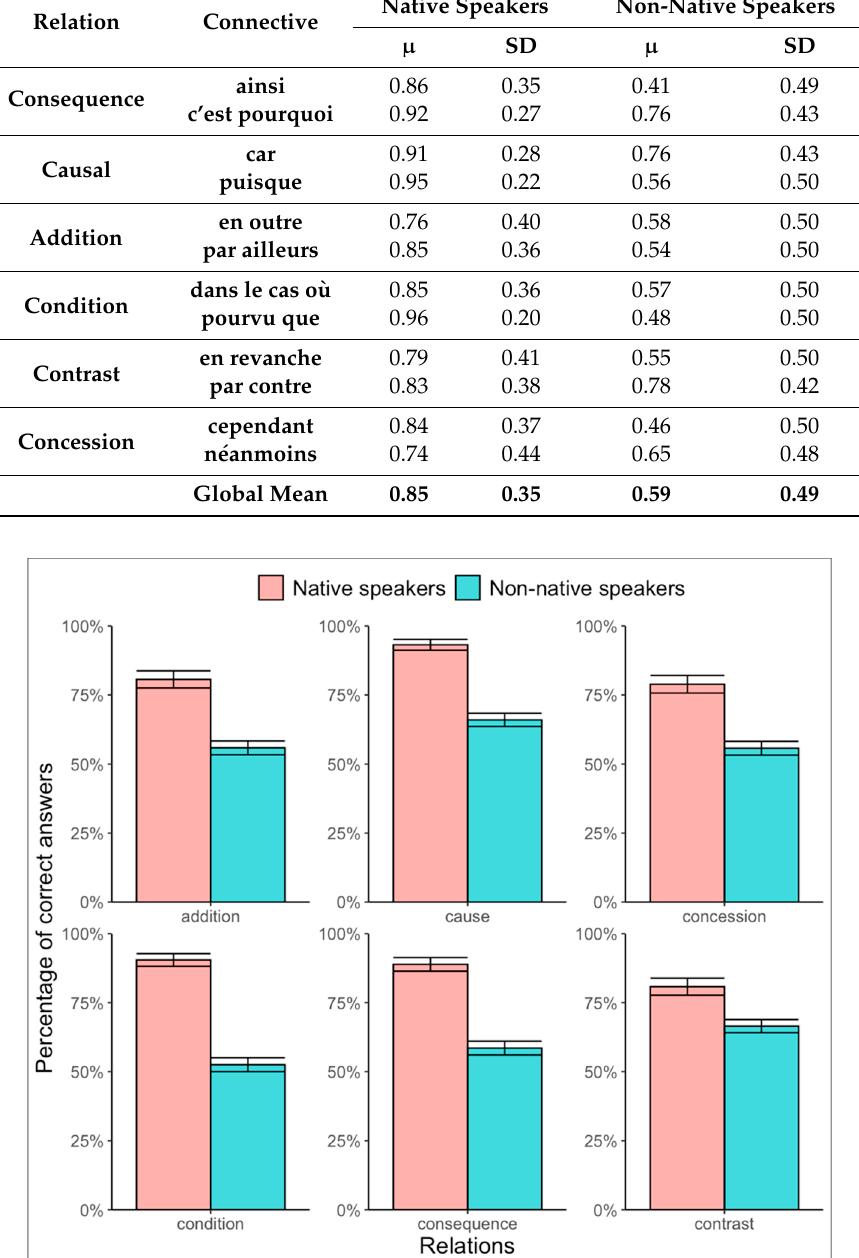
Figure 4. Percentage of correct answers in the main task by non-native and native speakers per relation (CI of 95% as error bars).